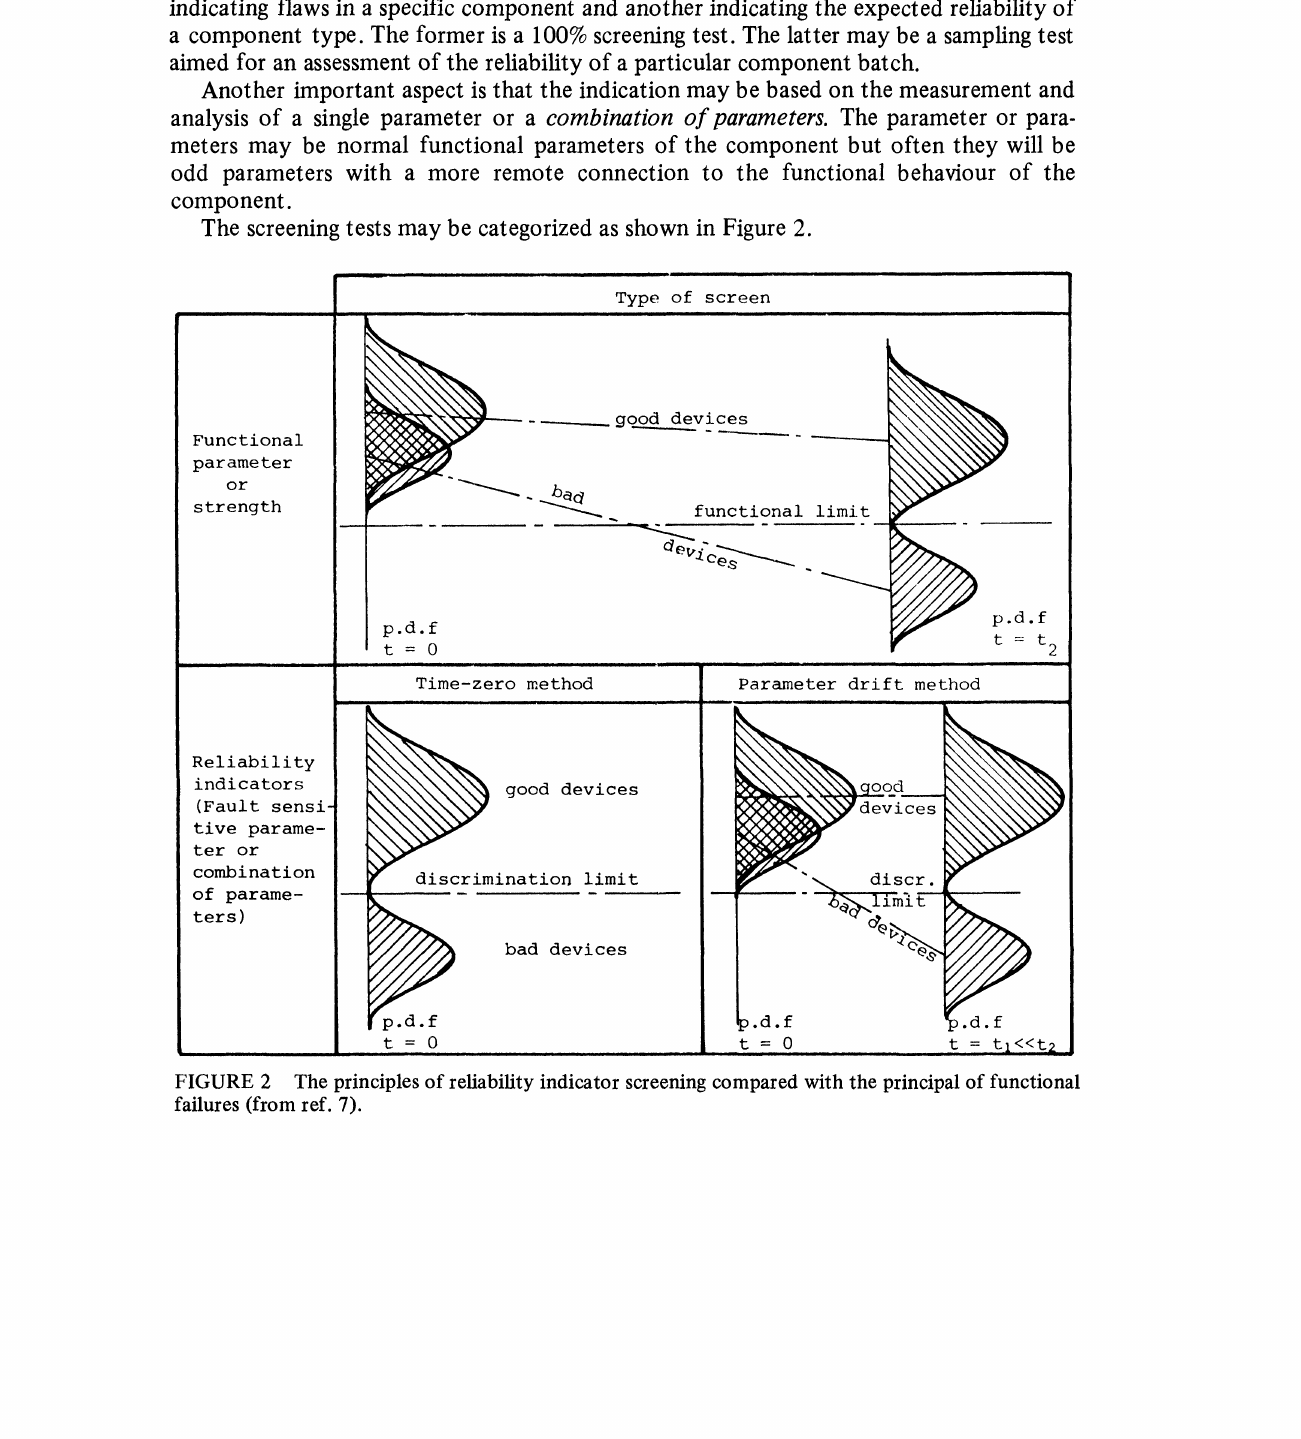
FIGURE 2 The principles of reliability indicator screening compared with the principal of functional failures (from ref.